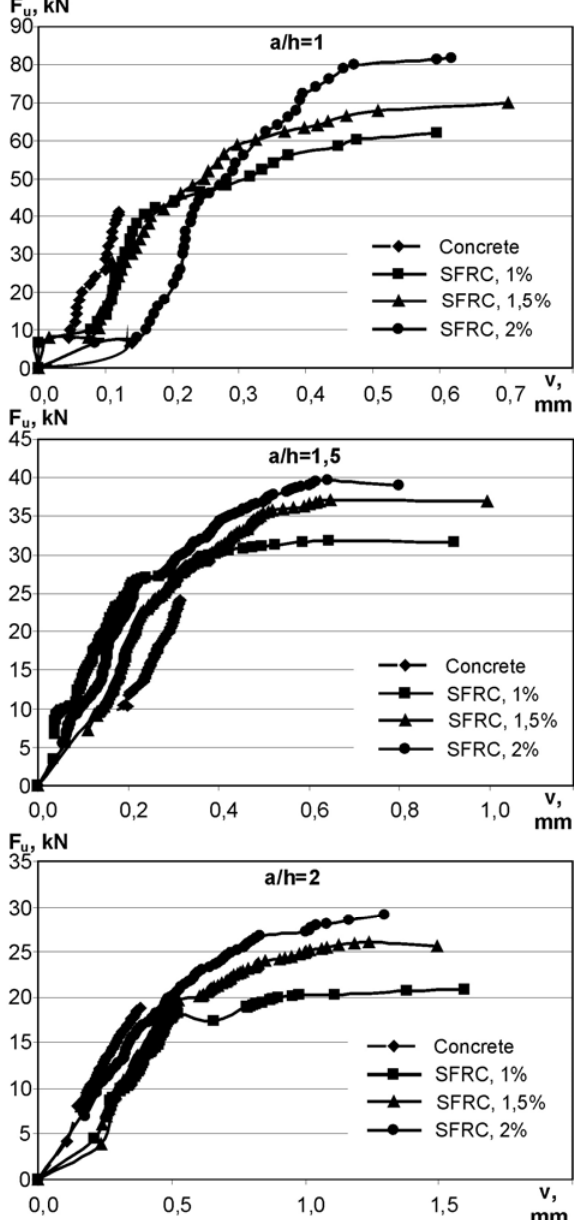
Fig 5. Load deflection curves with various fibre volumes V and shear span ratios / a h f Fibre volume nd shear span ratio / a h have f V a